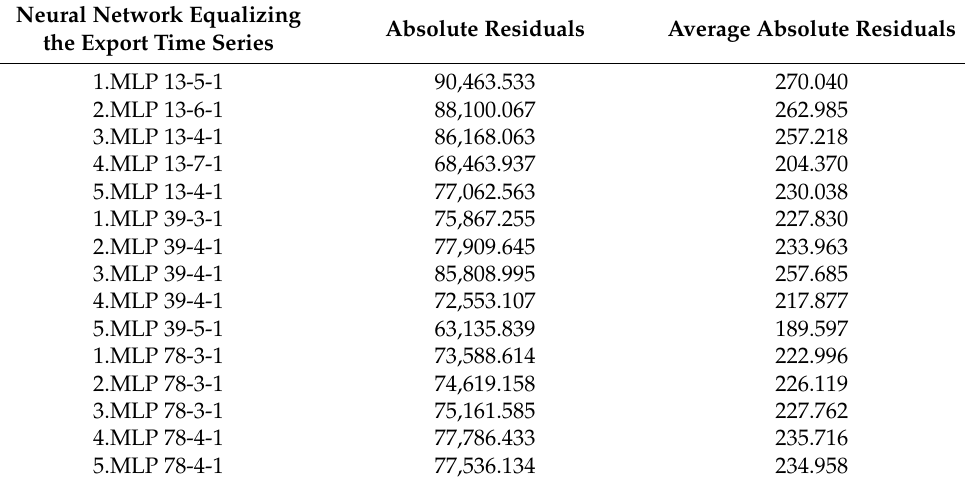
Table 3. Comparing absolute residuals of equalized time series.